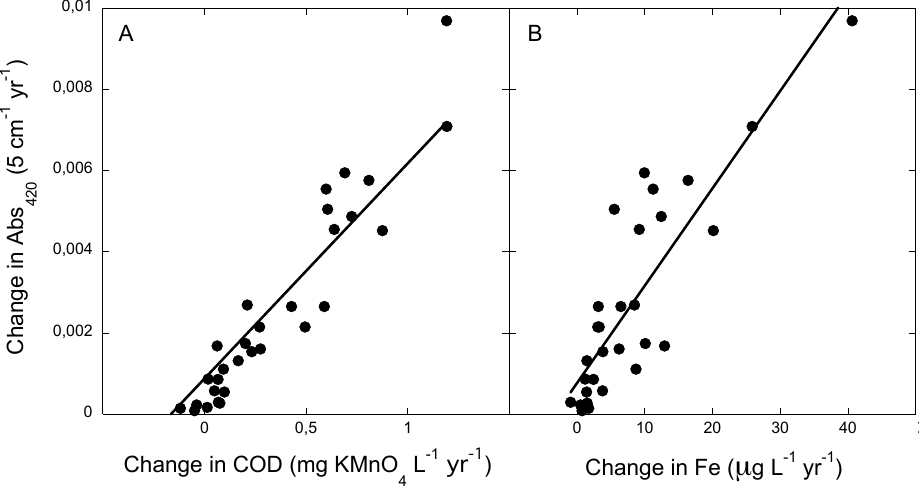
Fig. 4. Changes in Abs 420 correspond to changes in COD (Abs 420 = 0.0064 × COD + 0.0004, r 2 = 0 . 90, p < 0 . 001, panel A) and Fe (Abs 420 = 0.0002 × Fe + 0.0008, r 2 = 0 . 75, p < 0 . 001, panel B). Each point represents a single river.